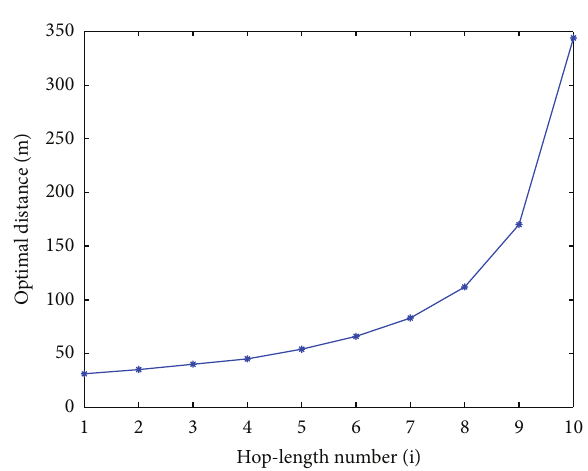
Figure 10: Optimal distances versus hop-length